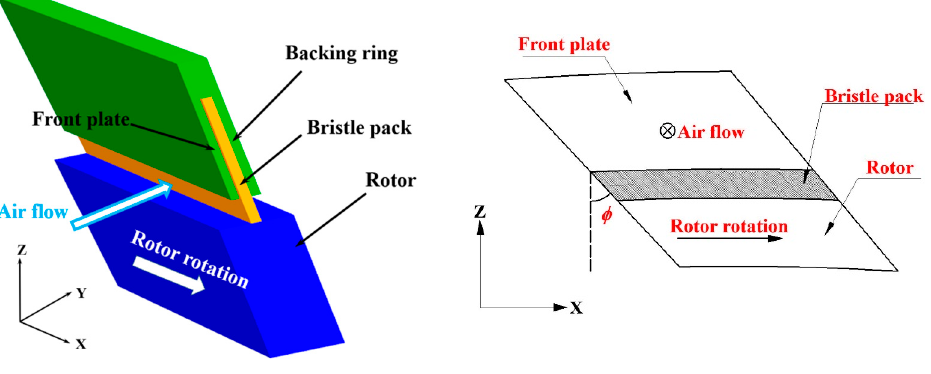
Figure 1. Brush seal structure.